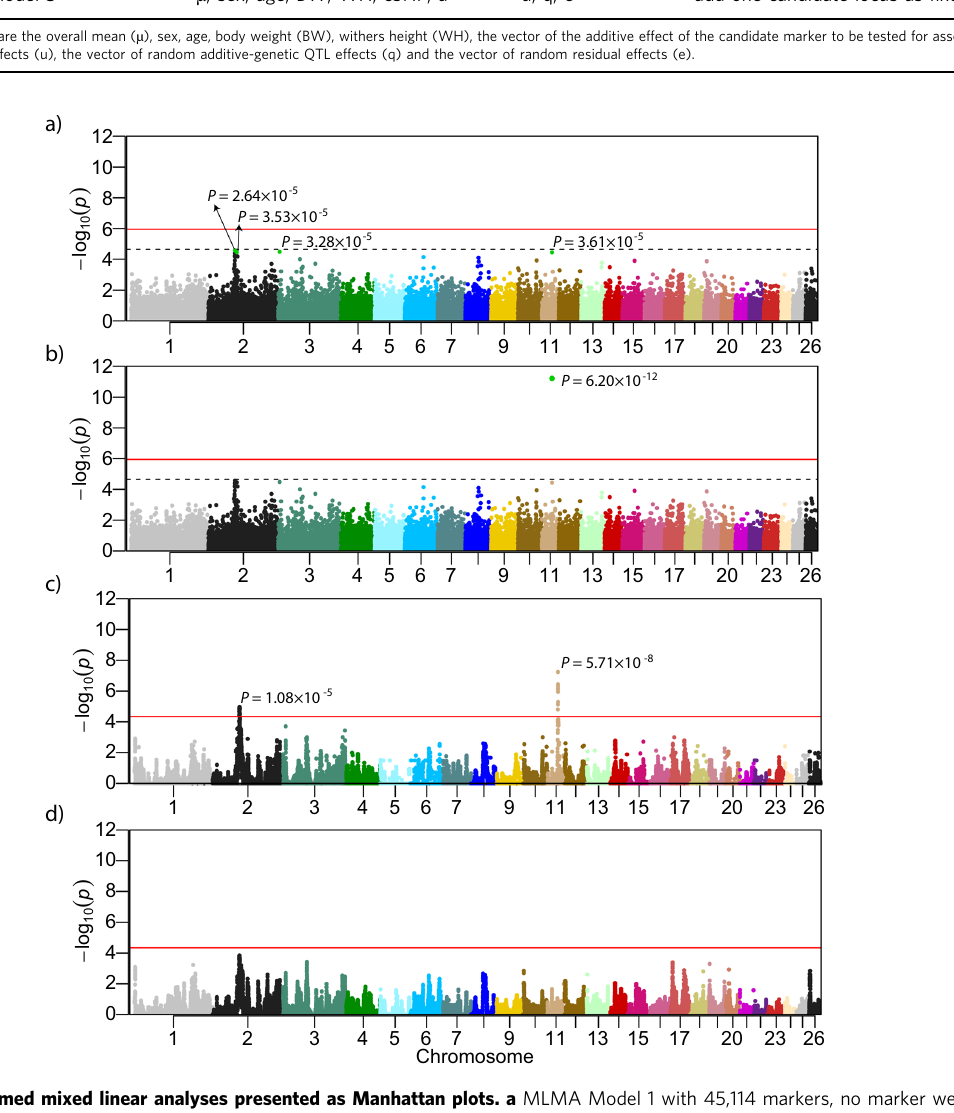
Fig. 1 Results of performed mixed linear analyses presented as Manhattan plots. a MLMA Model 1 with 45,114 markers, no marker were above the suggestive line, the four markers with the lowest p values are shown; b MLMA Model 2 with 45,115 markers, the additionally added candidate locus on OAR11 shows genome-wide signi fi cance; c cLDLA Model 3 with 45,114 markers resulted in two genome-wide signi fi cant peaks on OAR2 and OAR11; d cLDLA Model 5 with 45,115 markers and candidate locus added as fi xed effect, the peak on OAR2 decreases below the genome-wide signi fi cance and the peak on OAR11 erases